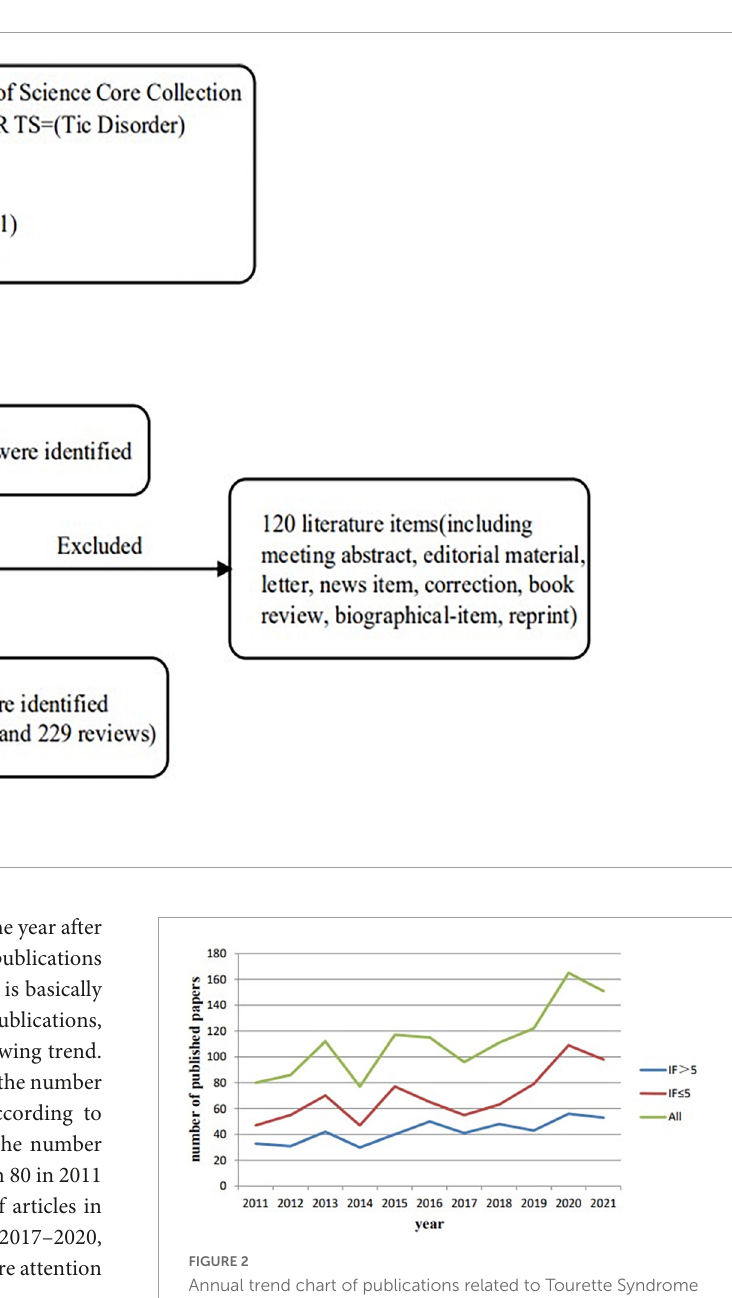
Germany (9.82%), and China (9.09%). The analysis revealed that the top five countries/regions in terms of centrality were Hungary (0.51), Scotland (0.42), France (0.41), the Netherlands (0.31), and Australia (0.24). According to Figure 3 , there was no significant difference in national cooperation structure before and after COVID-19. Meanwhile, the graph of country-based research networks shows a lower density, which suggests that research teams are relatively independent and highlights the need for more